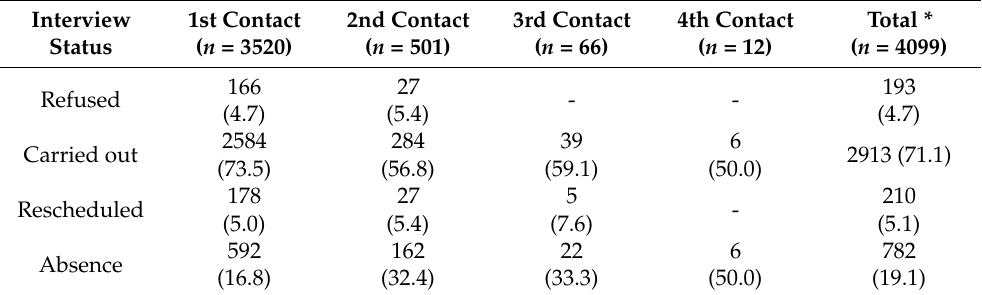
Table 1. Adherence process to the first (face-to-face) 24H-DR measurement amongst the participants in the third wave of the ELSA-Brasil study. S ã o Paulo,